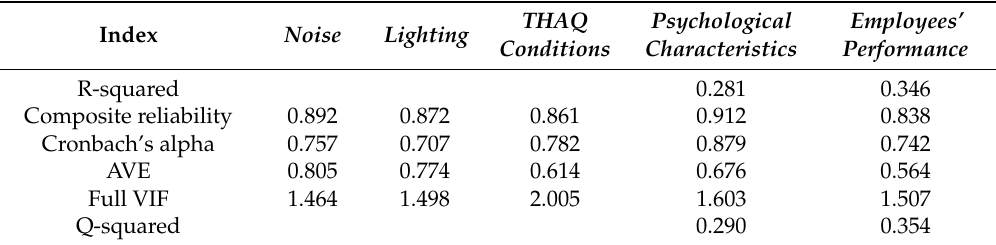
Table 8. MCQ validation. AVE, average variance extracted.